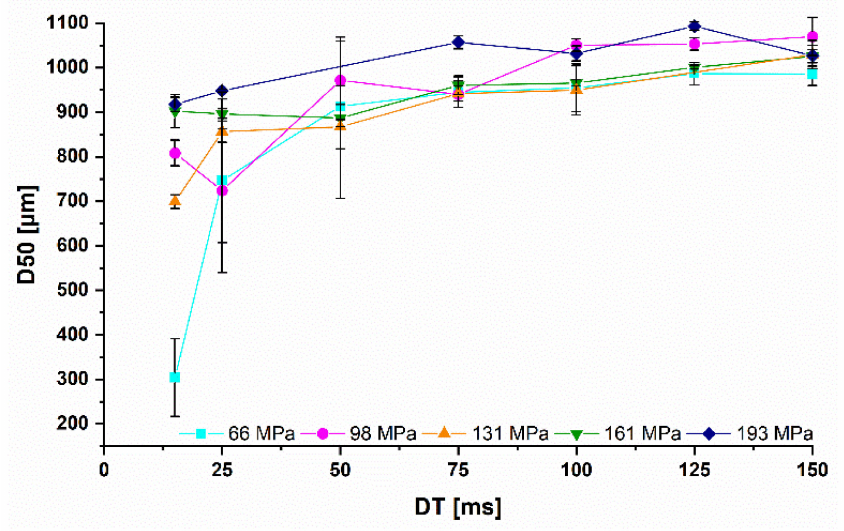
Figure 11. Influence of the dwell time on the median granule size of lactose granules at different P max from 66 to 193 MPa; x ± s ; n =